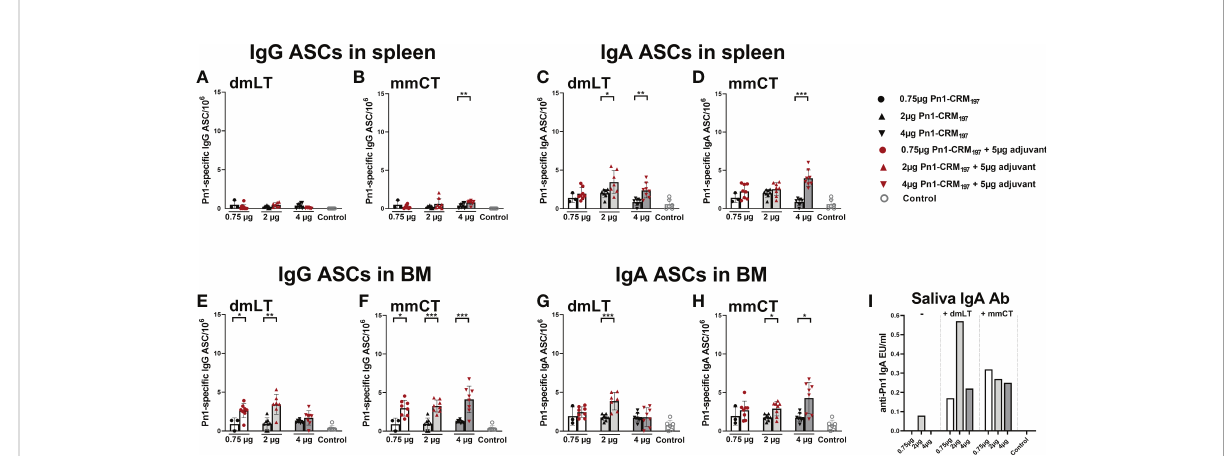
FIGURE 6 Effects of i.n. immunization with dmLT or mmCT on persistence of Pn1-speci fi c AbSCs in spleen and bone marrow and Pn1-speci fi c IgA Abs in saliva. IgG and IgA AbSCs in spleen (A – D) and BM (E – H) , and IgA in saliva (I) 8 weeks after immunization of neonatal mice with Pn1-CRM 197 alone s.c. or with dmLT or mmCT intranasally. Results are expressed as number of spots/10 6 cells (mean ± SD), IgG or IgA levels (EU/ml) in 6 – 8 mice per group and statistical difference was calculated using Mann – Whitney U-test where adjuvant groups were compared to vaccine only group. *p < 0.05, **p < 0.01, ***p <